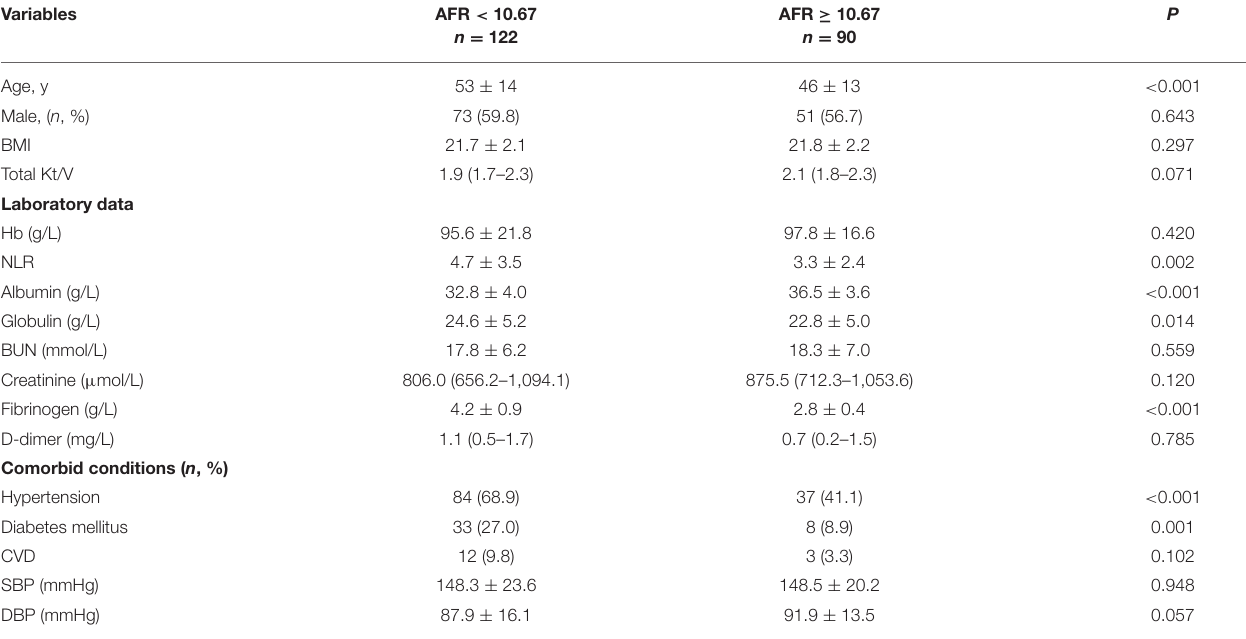
TABLE 1 | Baseline characteristics according to